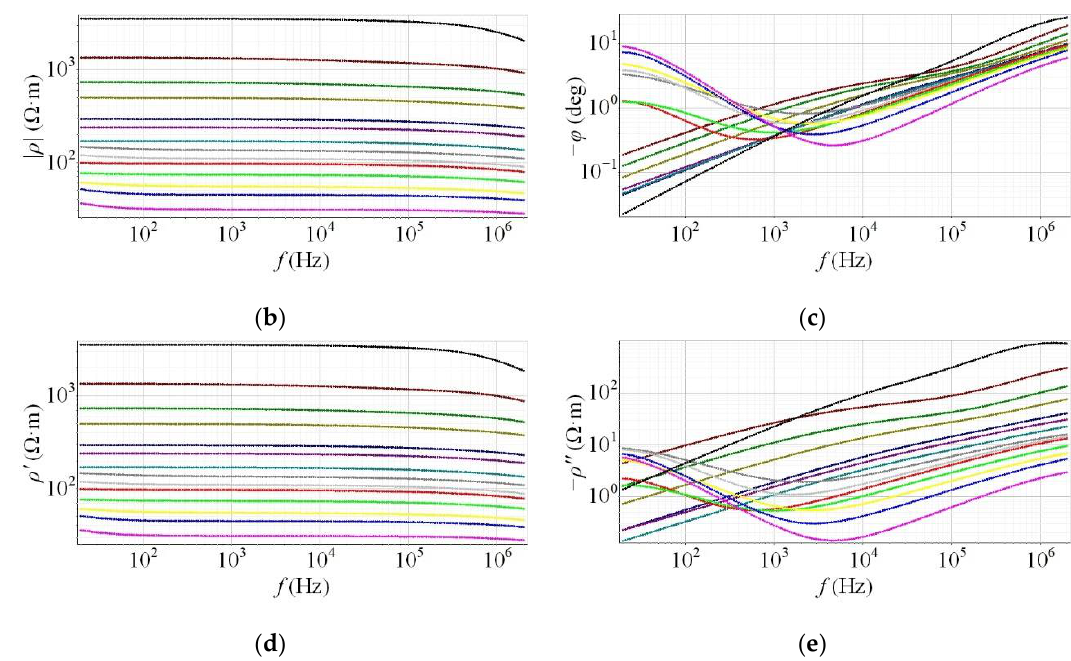
Figure A2. Impact of changes in volumetric water content on complex resistivity of substrate. ( a ) Nyquist plots; ( b ) magnitude spectra; ( c ) phase spectra; ( d ) in-phase conductivity spectra; ( e ) quadrature conductivity spectra. For the spectra marked by different colors, the variable volumetric water contents are provided in ( a ), while the related dry densities (Table 1) are considered to be nearly equal. The frequency range is from 20 Hz to 2 MHz.